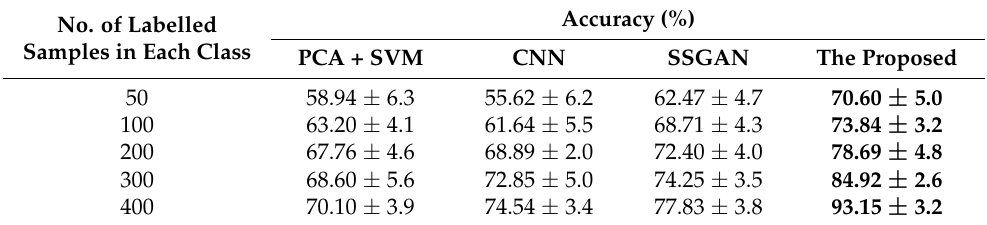
Table 1. Classification accuracy of samples with different numbers of labelled data.